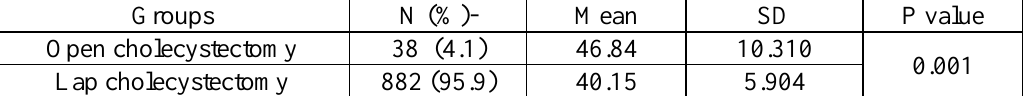
Table 1: distribution of studied cases according to age and cholecystectomy type